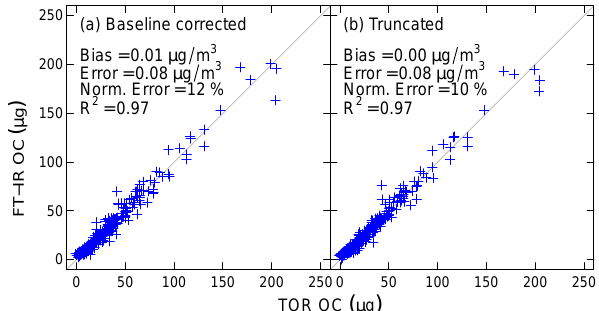
Figure 3. Predicted FT-IR OC versus measured TOR OC for the Base case test set with (a) baseline-corrected and (b) truncated spec- tra. Concentration units of µgm − 3 for bias and error are based on the IMPROVE nominal volume of 32.8m 3